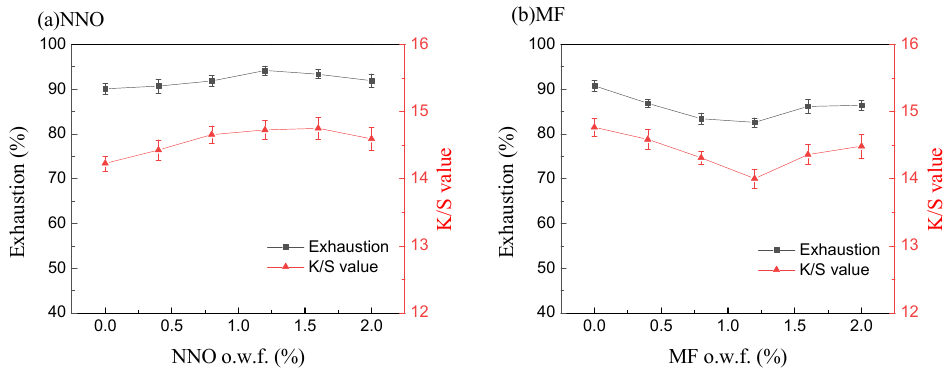
Figure 2. Influence of NNO ( a ) and MF ( b ) on the exhaustion of dye and the final K/S value of the dyed fabric.